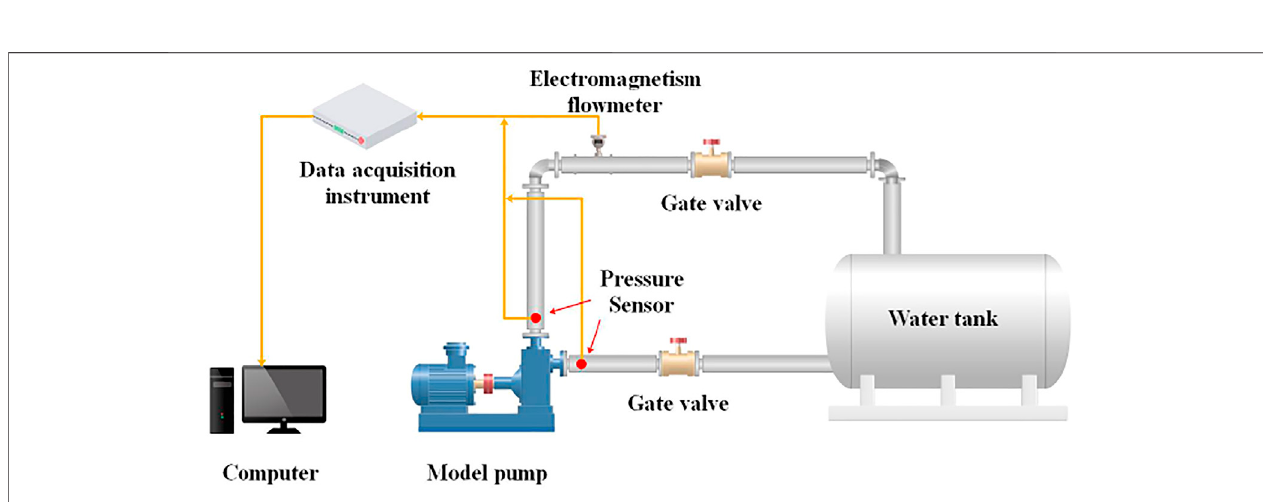
FIGURE 5 | The test apparatus and piping